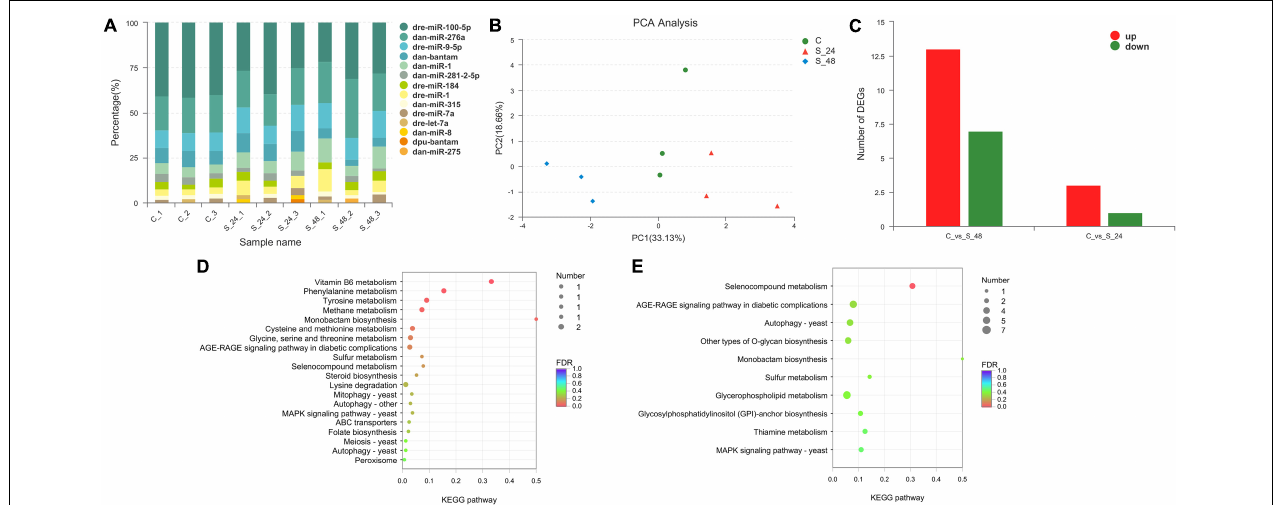
FIGURE 5 | Analysis of the miRNAs in Exopalaemon carinicauda . (A) Top10 expressed miRNAs in different experiment group. (B) Principal component analysis plot of the expression quality of different experiment group. The green circle showed the control group, and the red triangle showed the group after 24 h saline-alkali stress, while the blue rhombus showed the group after 48 h saline-alkali stress. (C) Differentially expressed miRNAs statistics in group C vs. S24 and C vs. S48 (C, control group; S24, acute saline-alkali stress for 24 h; S48 acute saline-alkali stress for 48 h). (D) KEGG analysis of the target genes for differentially expressed miRNAs after 24 h saline-alkali stress. (E) KEGG analysis of the target genes for differentially expressed miRNAs after 48 h saline-alkali stress.